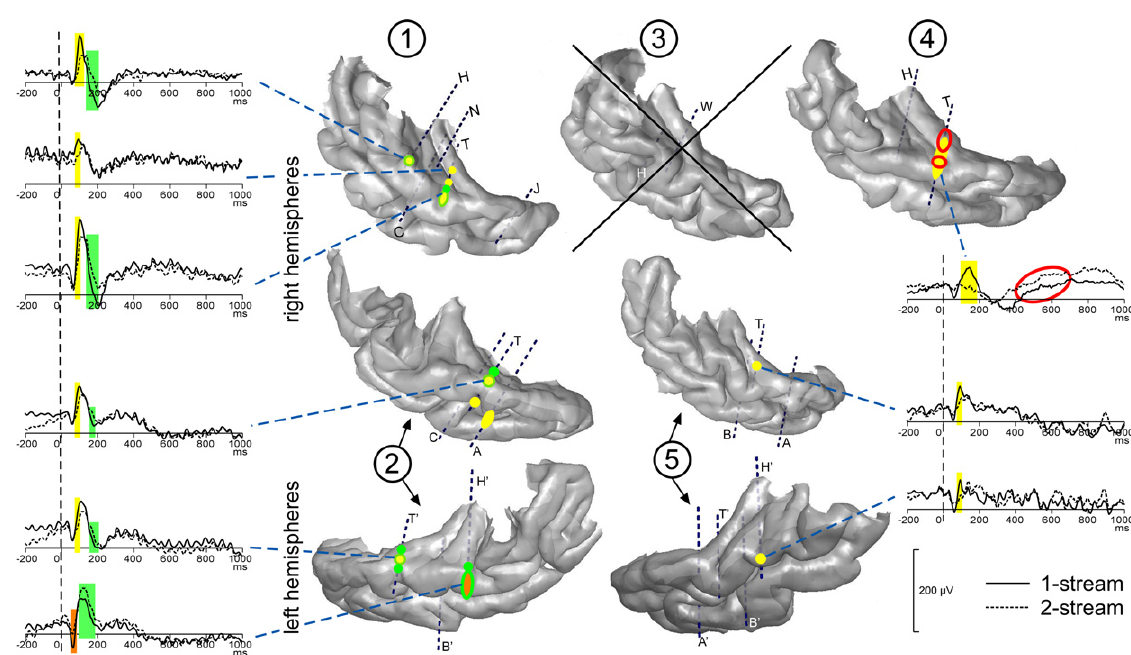
Figure 3. Modulations of evoked transient and sustained responses on the 3D rendering of individual temporal cortices. After the onset of part 2 (0 ms), three main transient waves were found more prominent in the 1-stream condition, on several contacts of the four patients kept for this analysis. A fi rst one was modulated between 60 and 80 ms (orange), a second one between 80 and 160 ms (yellow) and a third one between 120 and 200 ms (green). These effects were mainly located on the lateral STG and their time-courses are depicted. In patient #4, effects on the sustained response were found between 200 and 700 ms: mean amplitude was greater in the 2-stream condition (red circles). Yellow-green hatchings correspond to electrode contacts where both second and third effects are present. These evoked responses are baseline corrected with respect to the (−100, 0 ms) period preceding part 1. Each number corresponds to a patient, patients #2 and 5 being implanted in both hemispheres.